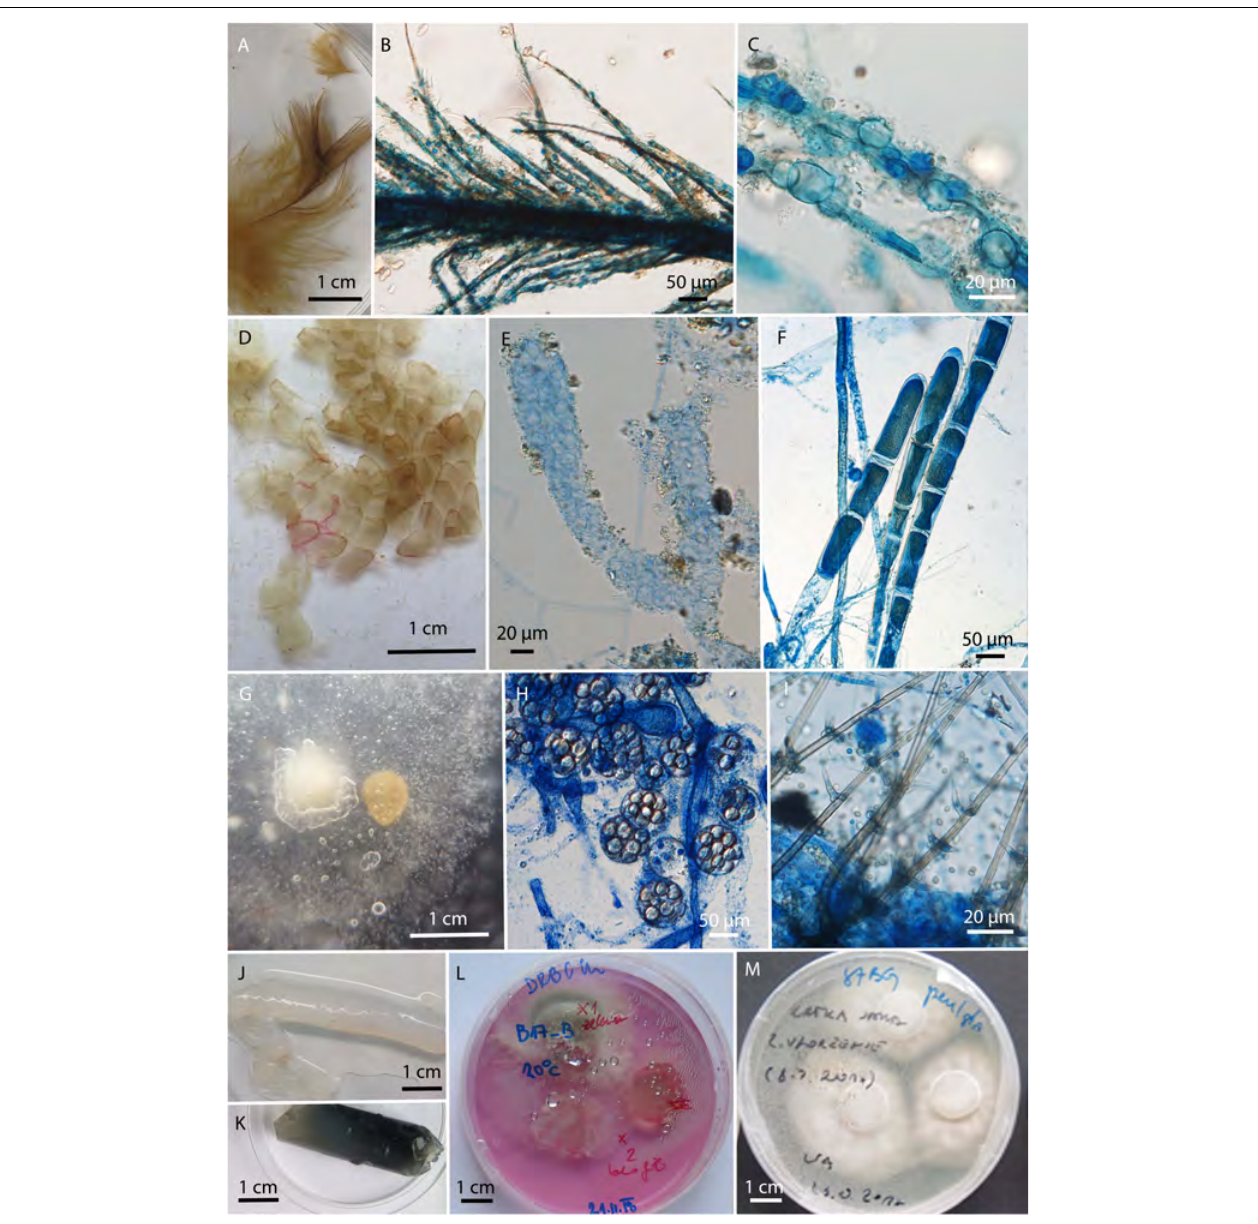
FIGURE 6 | Microbiological baits after incubation in the environmental water. (A–C) Bird feathers colonized by unknown chytrid; (D) molten snake skin; (E–F) unknown filamentous organism growing on molten snake skin; (G) canopy seeds after incubation, overgrown with (H) Saprolegnia () and (I) Chloridium aseptatum ; (J,K) dialysis tubes filled with water agar; (L,M) cut pieces of agar after incubation on isolation culture media.